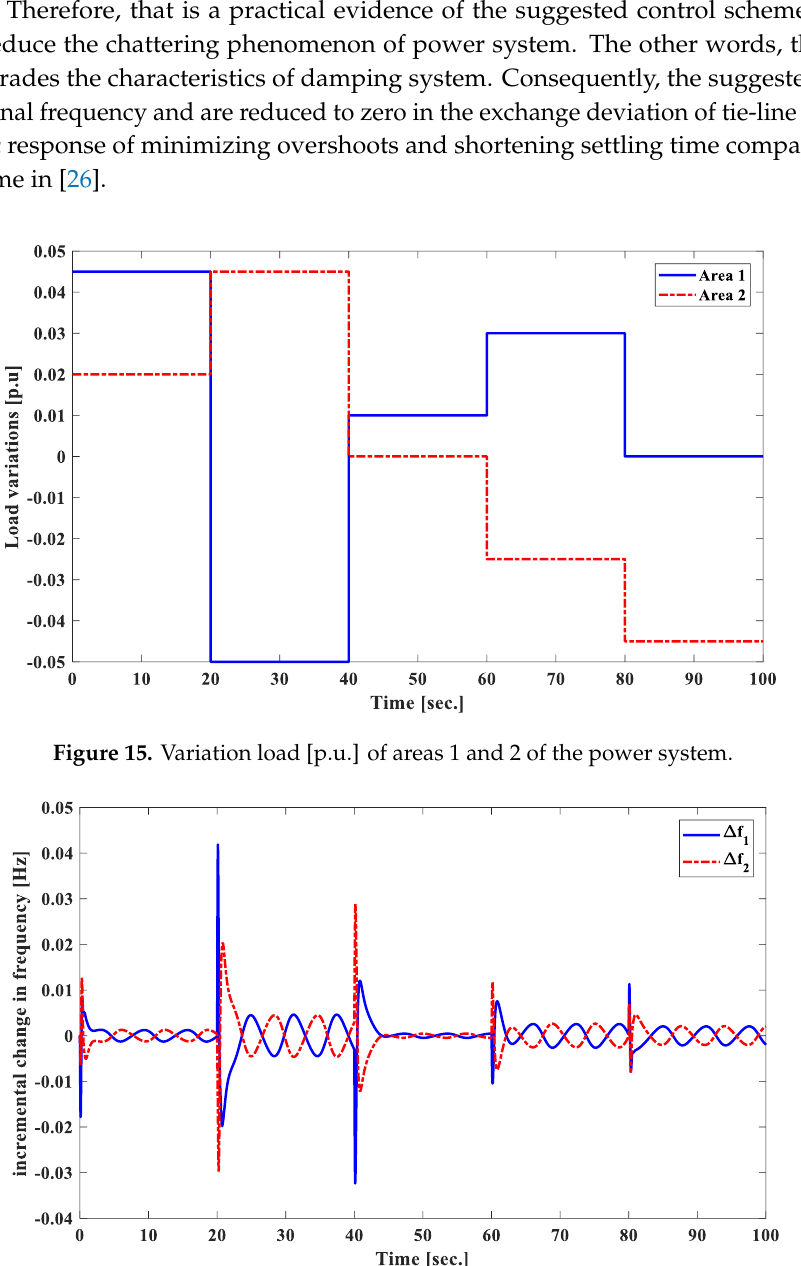
Figure 17. Tie-line power [p.u.MW] under load variations and the mismatched parameter uncertainties.